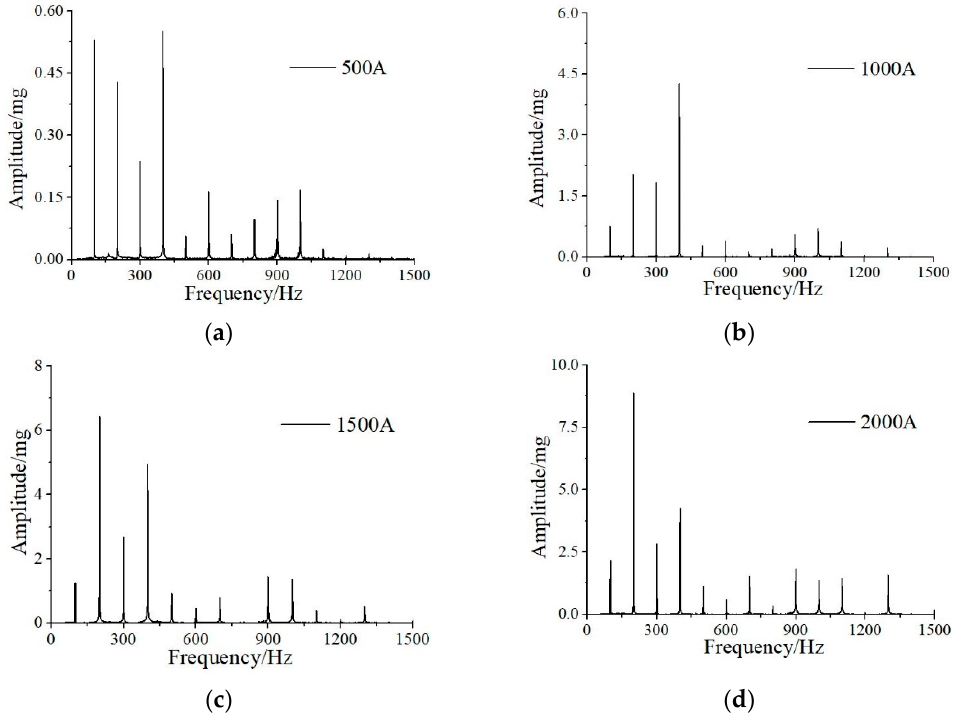
Figure 14. Frequency domain waveforms under the serious poor contact case: ( a ) 500 A; ( b ) 1000 A; ( c ) 1500 A; ( d ) 2000 A.